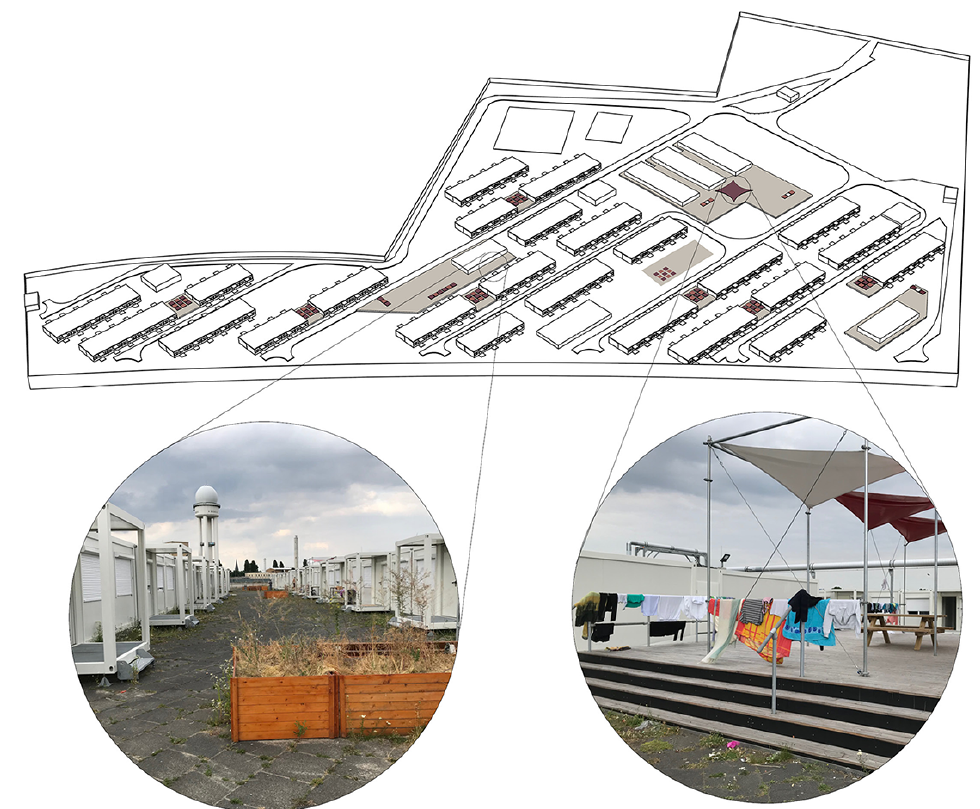
Figure 6. The Tempohome at Columbia-Damm (Tempelhof) showing designed social spaces and how they are appropriated or left unused. Source: Darweesh, Dalal and Misselwitz in